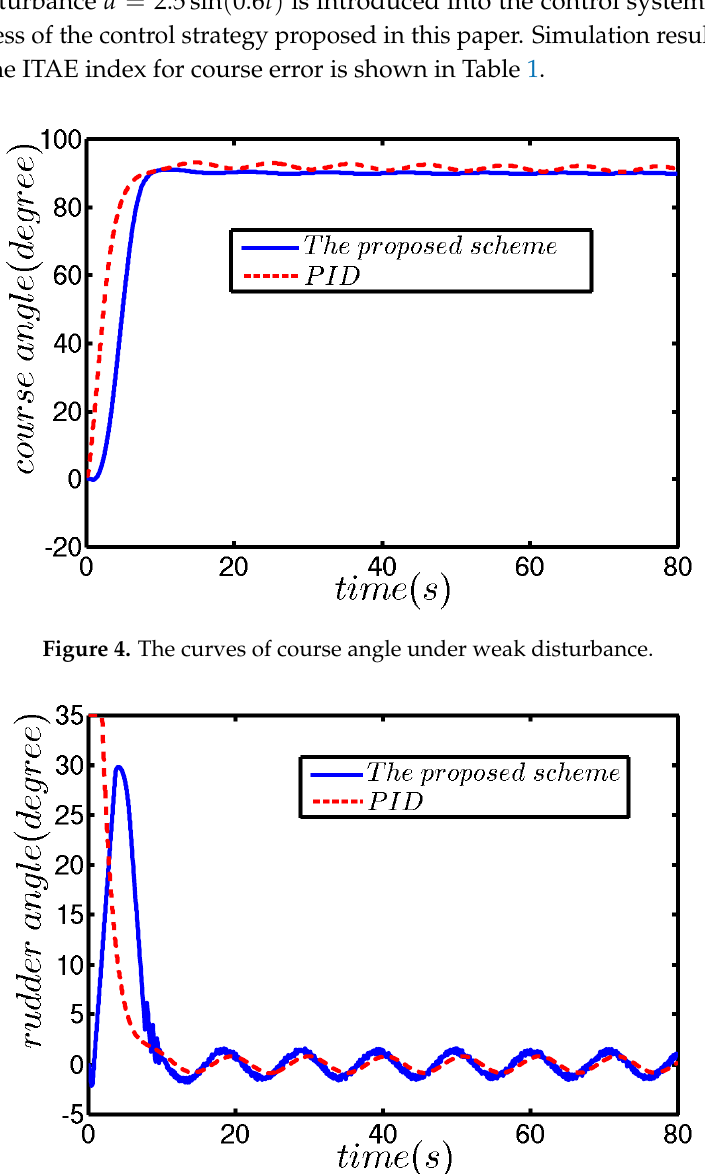
Figure 5. The curves of rudder angle under weak